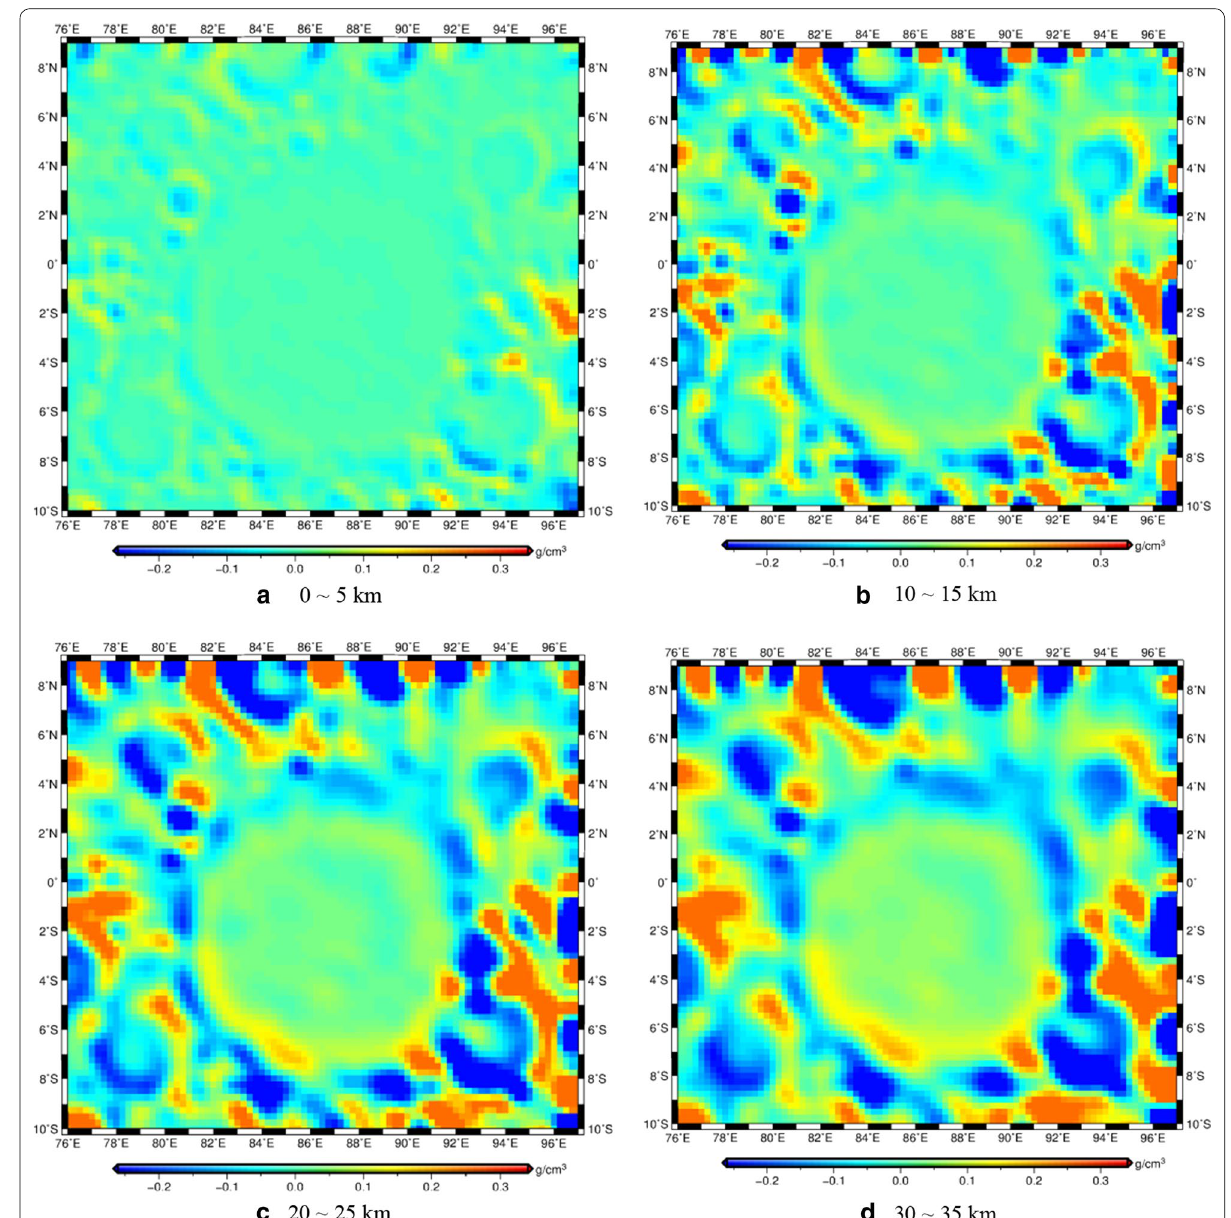
Fig. 16 Relative density distribution for different depths at Mare Smythii area, a , b , c and d are 0 ~ 5 km, 10 ~ 15 km, 20 ~ 25 km and 30 ~ 35 km,